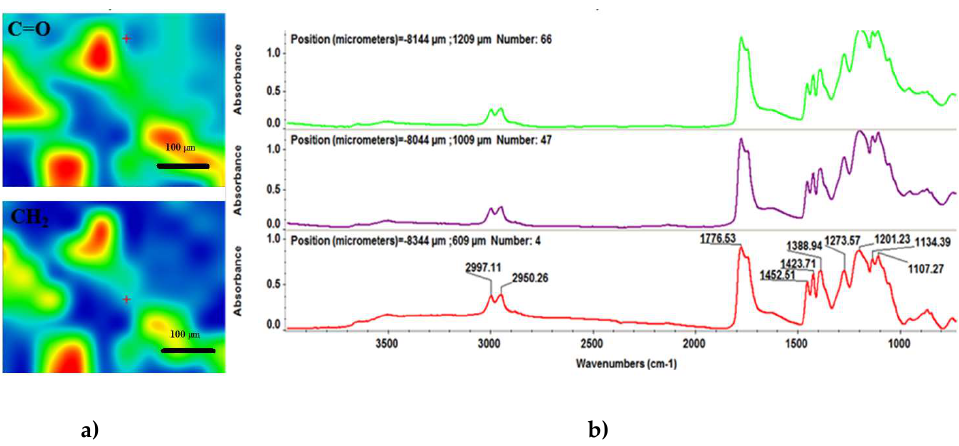
Figure 5. Infrared micrographs ( a ) and corresponding infrared spectra ( b ) of PLGA/Fe 3 O 4 @CEF dropcast coating.